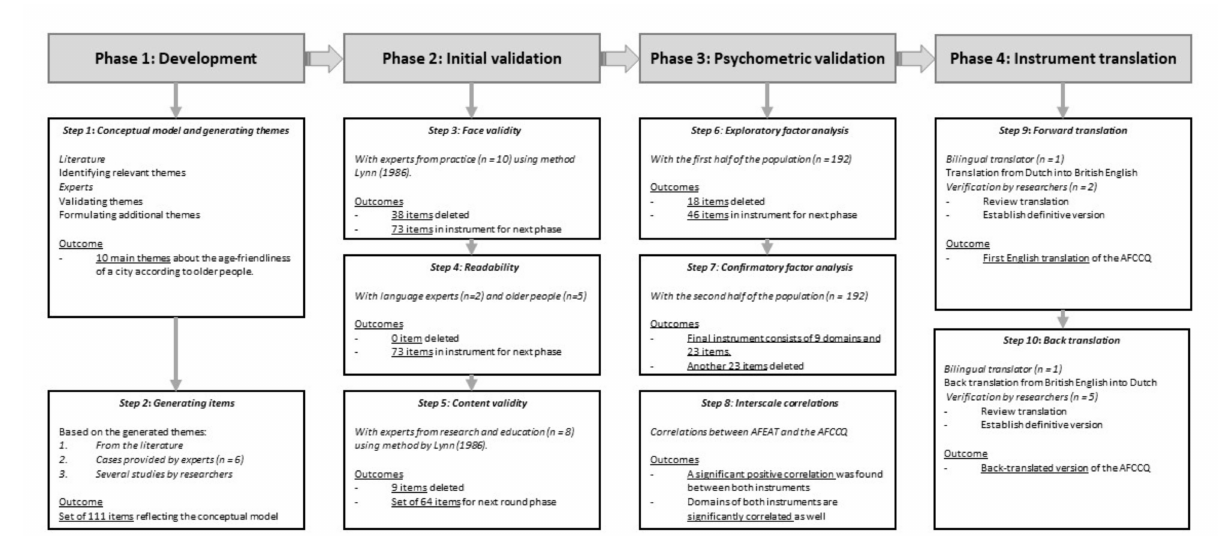
Figure 1. Flowchart representing the phases and steps for developing the Age-Friendly Cities and Communities Question- naire (AFCCQ). Step 7 had 9 domains and 23 items as the final outcome. Please note that in §2.2.2. of the paper [26] step 2.1 should be step 3, and in §2.2.4 of the paper, step 2.3 should be step